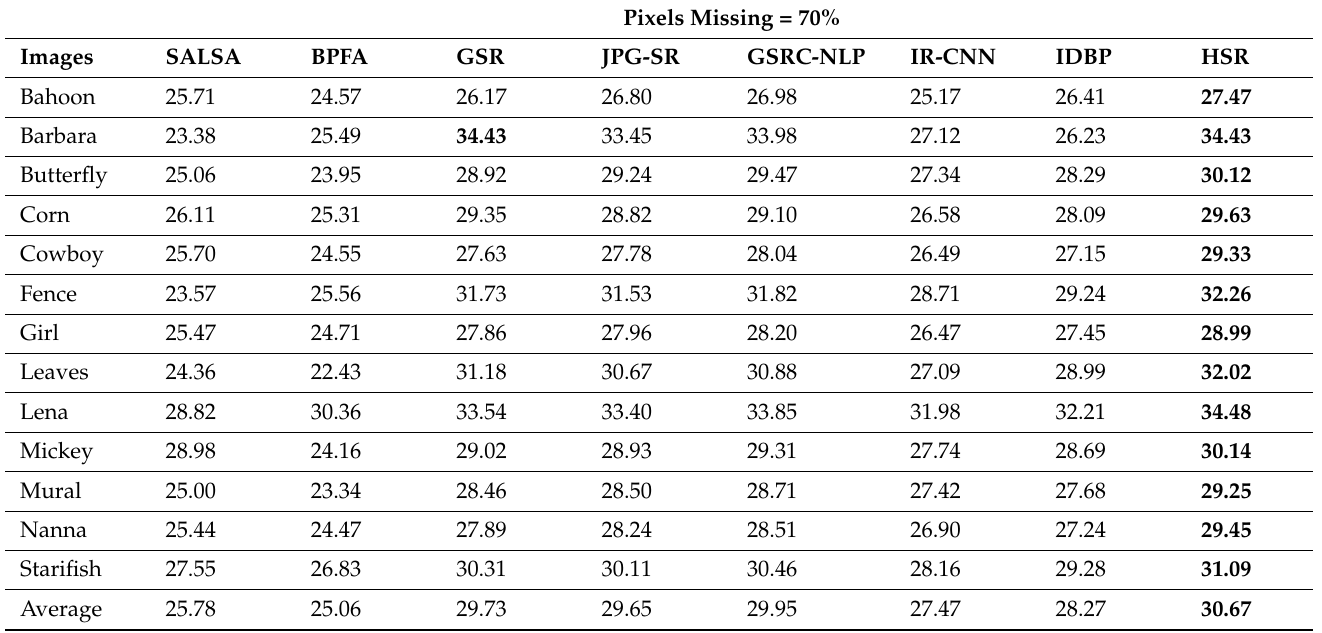
Table 2. PSNR values of our proposed HSR model and other comparison models after image restoration with pixels missing rate 70%. Pixels Missing =